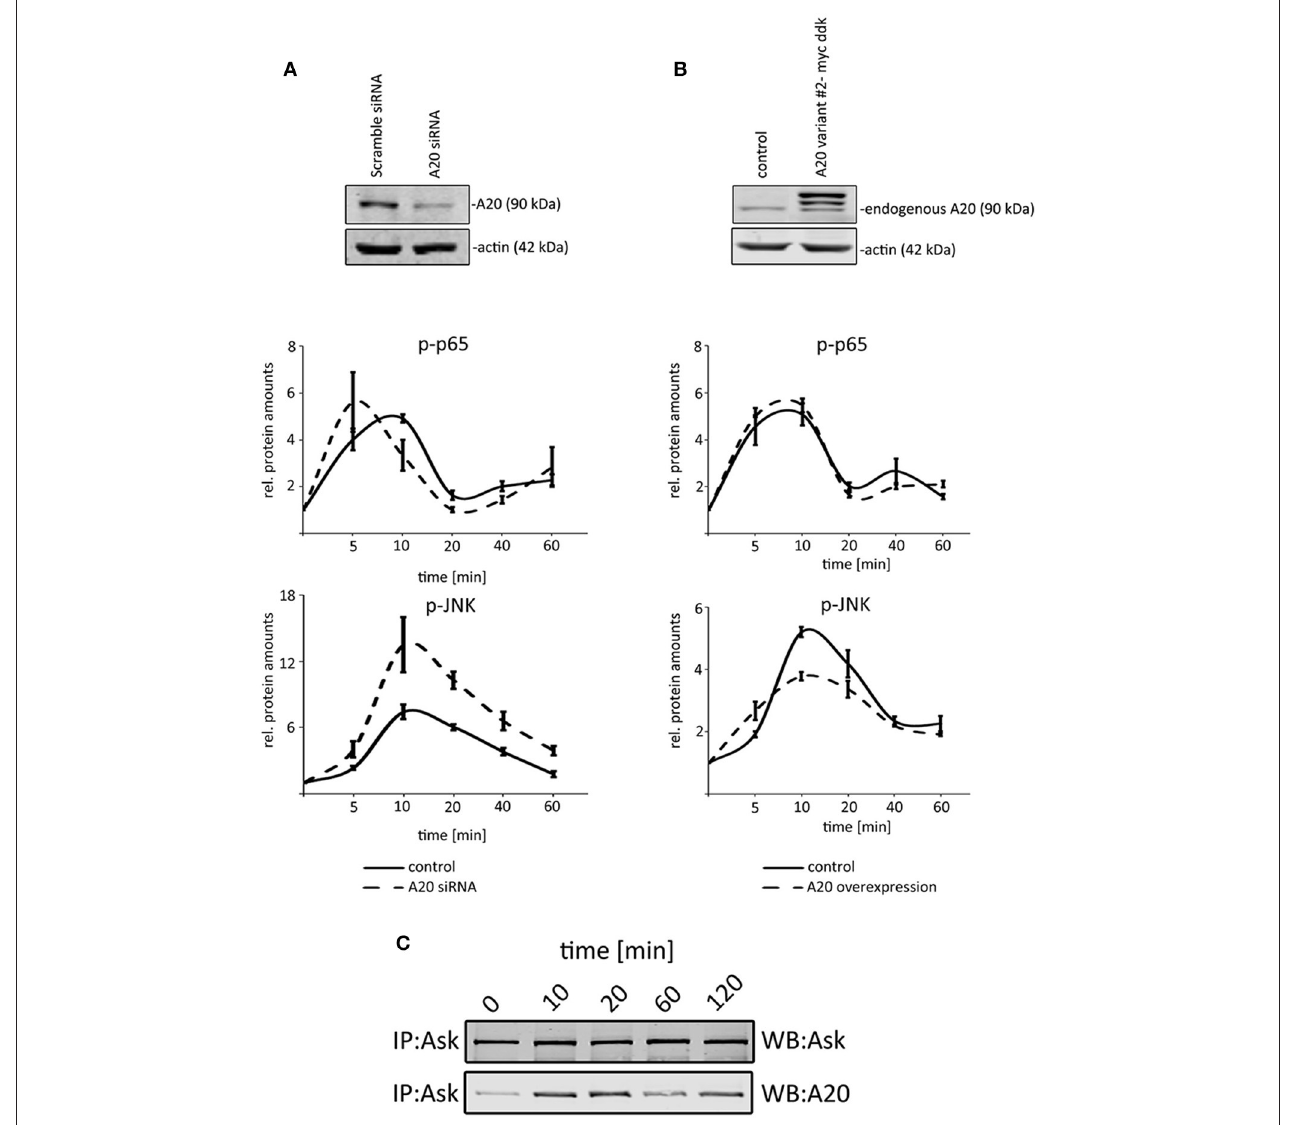
FIGURE 5 | A20 negatively regulated JNK signaling in hepatocellular cells. (A) The overexpression of A20 is confirmed by western immunoblotting. Endogenous A20 and exogenous A20 were detected. Kinetics illustrate that NF- κ B signaling is not affected after increasing A20 levels, while the phosphorylation of JNK is reduced after TNF administration (10 ng/ml). (B) The siRNA-mediated knockdown of A20 is confirmed by western immunoblotting. Kinetics after TNF administration (10 ng/ml) showed that JNK phosphorylation increased compared to controls. p65/phospho-p65 and JNK/phospho-JNK were quantified and normalized to the respective loading control (actin). All graphs summarize the results from three independent analyses. Bars represent standard errors. (C) Co-immunoprecipitation experiment detecting the physical interaction between A20 and ASK1 after TNF stimulation at indicated time points. The detection of ASK1 illustrates that the protein is not differentially expressed after TNF administration. IP: immunoprecipitation; WB: Western